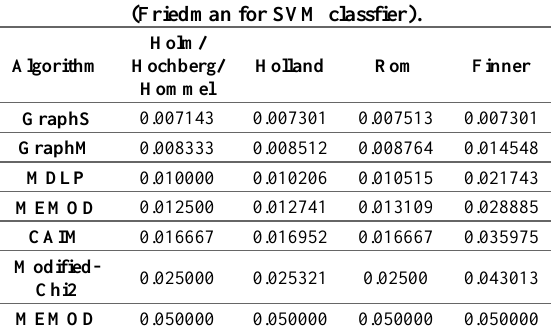
Table 10. Post Hoc comparison Table for 𝜶 = 𝟎. 𝟎𝟓 (Friedman for SVM